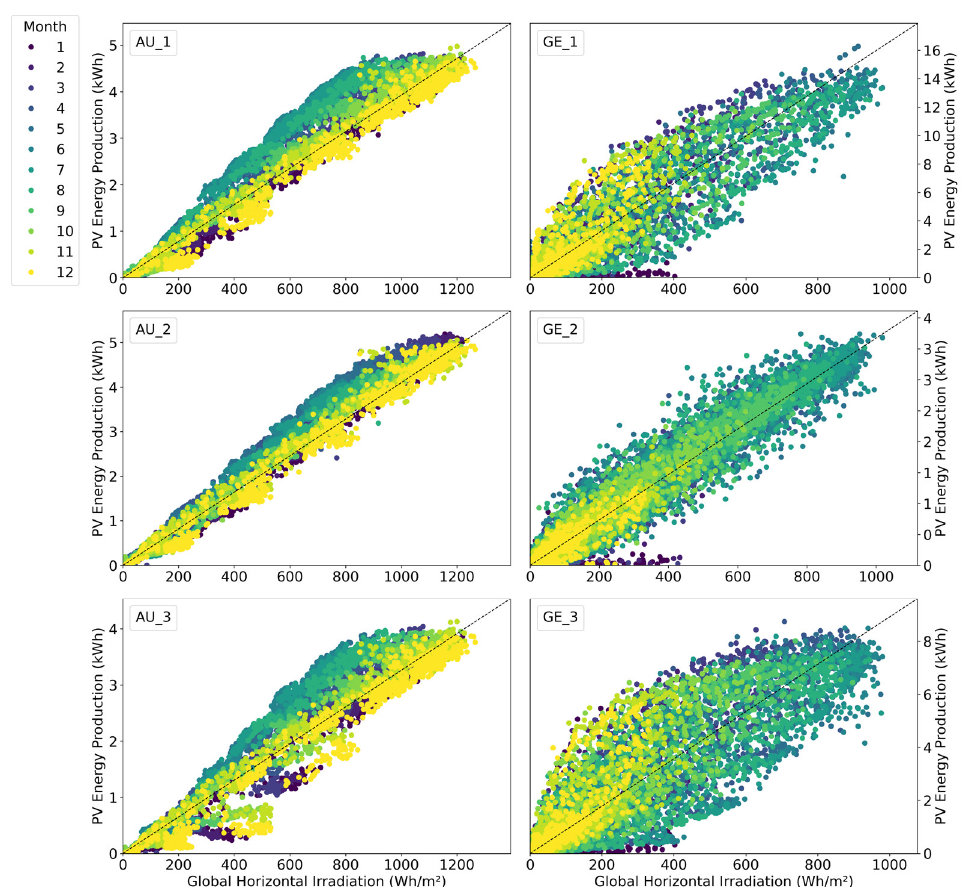
Figure 8. Relation between PV energy production (kWh) and global horizontal irradiation (Wh/m 2 ) for the different locations.